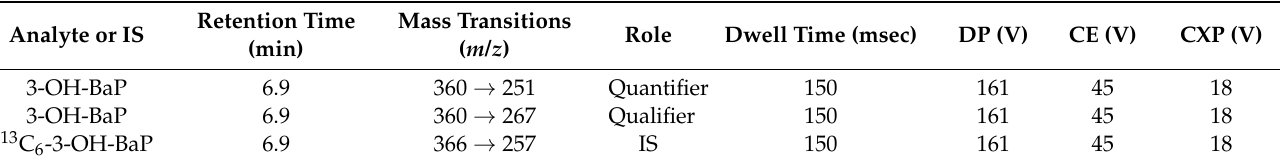
Table 1. Retention times, mass transitions, dwell time, declustering potentials (DP), collision energies (CE), and cell exit potentials (CXP) for 3-OH-BaP and 13 C 6 -3-OH-BaP. Analyte or